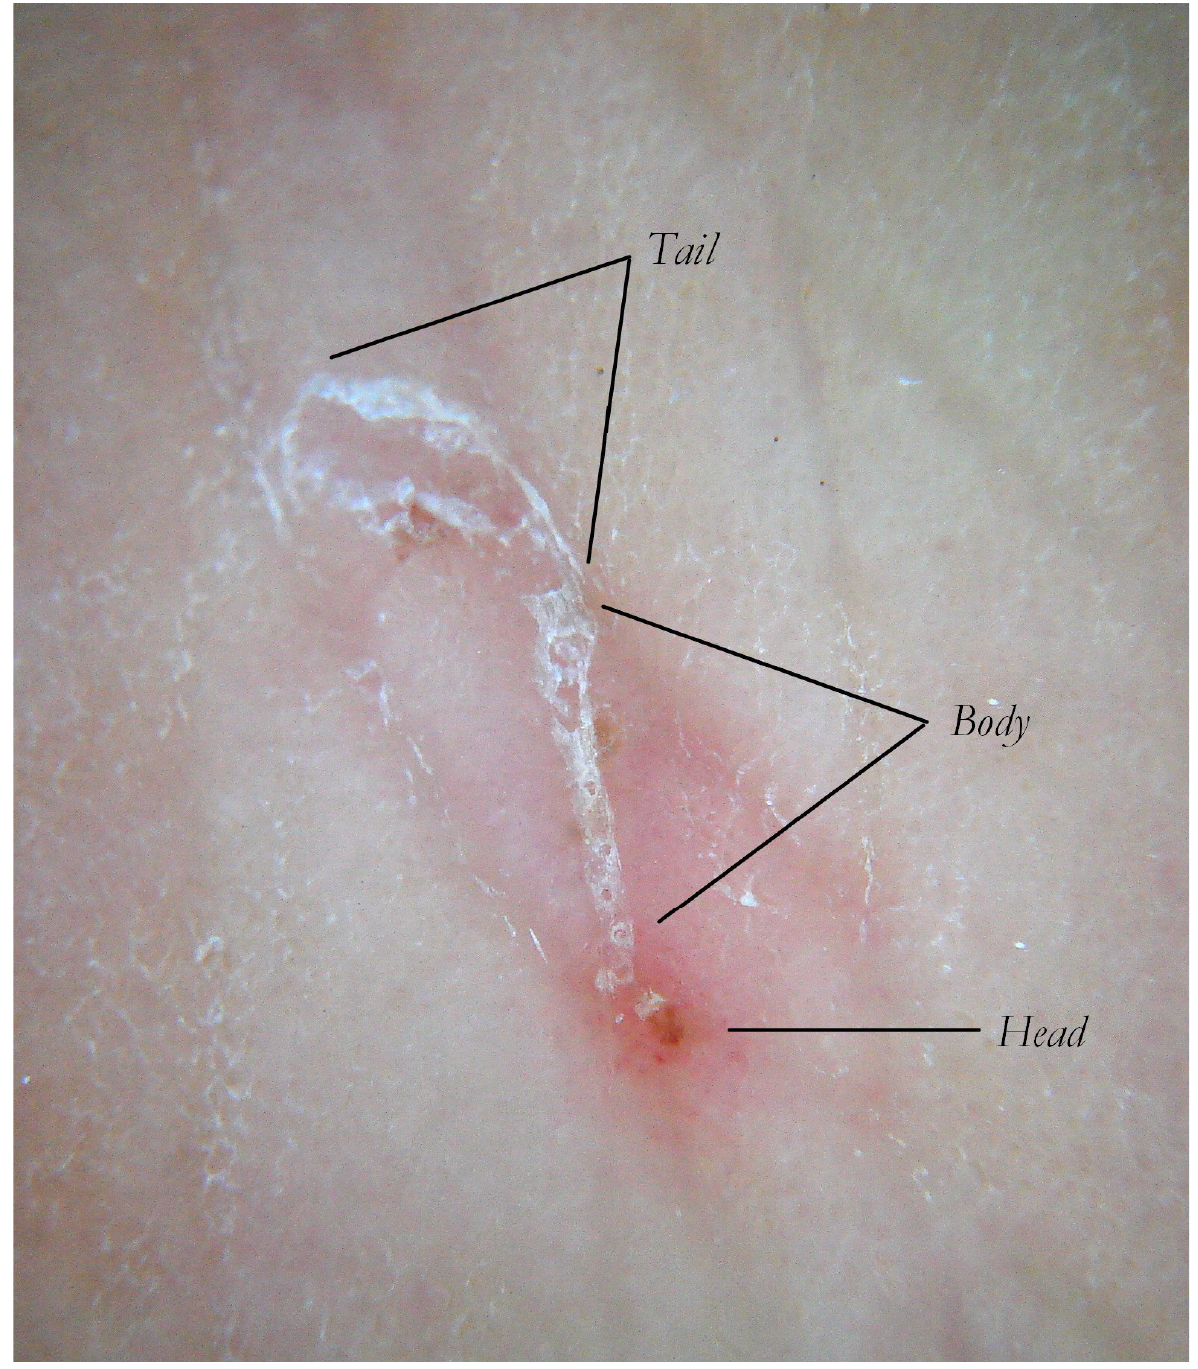
Figure 1. The Mite ‐ Gallery Unit in non ‐ polarized dry dermoscopy (d ‐ DS). MGU can be divided into three parts. The Head hosts the mite, the Body contains parasite eggs and feces and the Tail, which has not roof but features keratinic collarettes that are visible only in d ‐ DS. An erythema is present in the background around and immediately behind the mite.